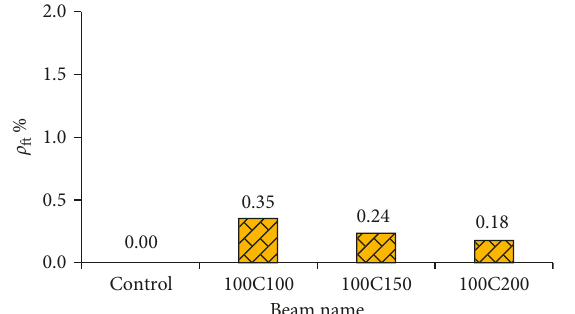
Figure 3: CFRP sheet reinforcement ratios for the strengthened beams.